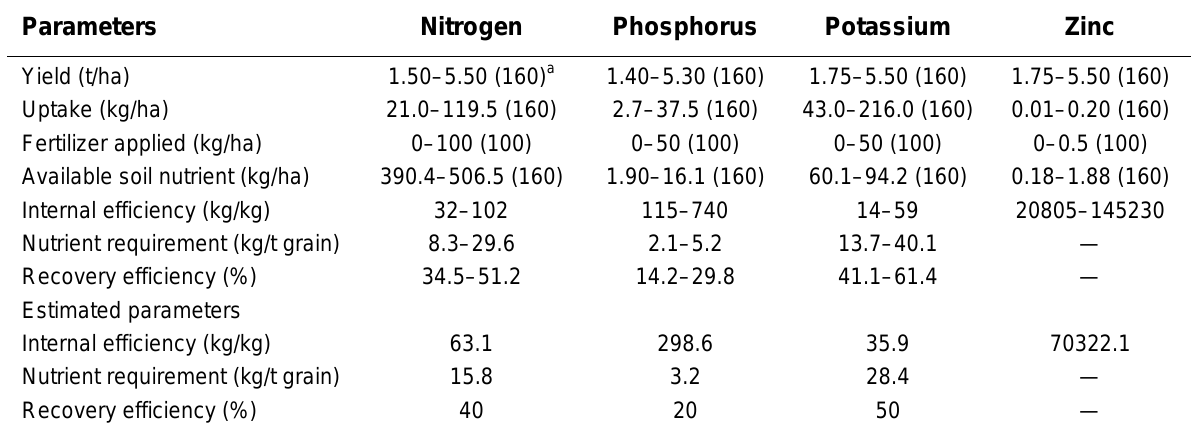
Range of Grain Yield of Wheat, Plant Nutrients, and Fertilizer Application Data Used for